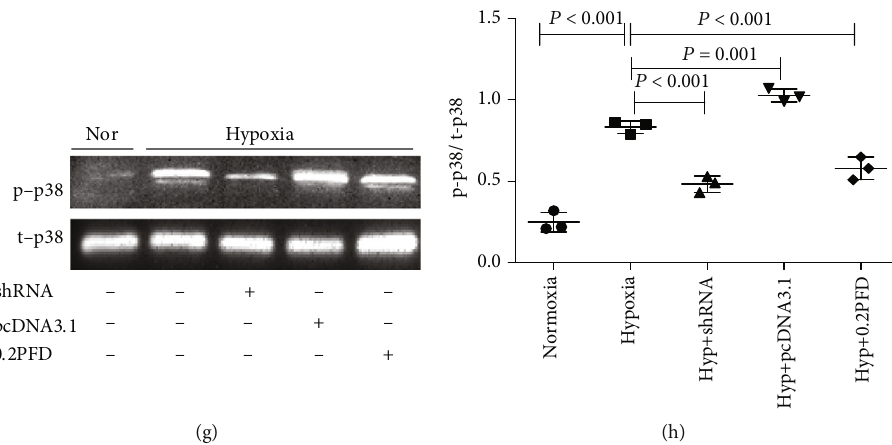
Figure 5: The PFD reduced the phosphorylation of p38 through the NOX4/ROS signaling pathway in HPAAFs exposed hypoxia. (a – d) Compared with normoxia, hypoxia increased the expression of NOX4 and ROS, while PFD reduced NOX4 protein expression and ROS expression in cultured HPAAFs ( n = 3 ). (e, f) NOX4 expression was e ff ectively interfered by shRNA or pcDNA3.1, and PFD signi fi cantly decreased the hypoxia-induced NOX4 expression ( n = 3 ). (g, h) NOX4 inhibition or PFD signi fi cantly decreased the phosphorylation of p38 induced by hypoxia in HPAAFs, and overexpression of NOX4 by pcDNA3.1 increased the expression of p-p38 ( n = 3 ). Nor: normoxia; Hyp: hypoxia; PFD: pirfenidone; p-p38: phosphorylated p38; t-p38: total p38; HPAAFs: human pulmonary arterial adventitial fi